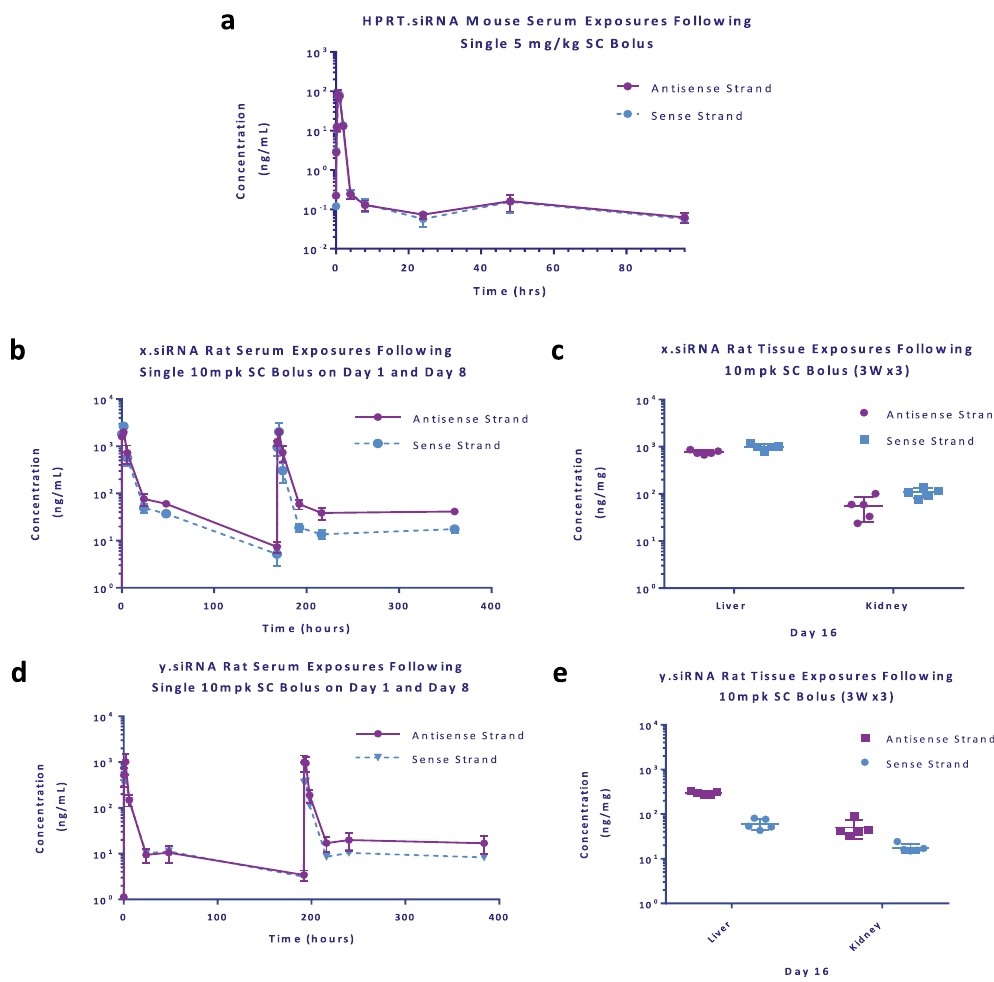
Figure 5. Serum concentration-time profile and tissue concentration of antisense and sense strands of HPRT. siRNA following a single SC bolus in C57BL/6 mice ( a ) 0–96 h in serum (n = 2 animals per time point). Serum concentration-time profile of x.siRNA ( b ) and y.siRNA ( d ) 0–48 h on day 1 and day 8 following a 10 mg/kg SC Bolus in male Sprague Dawley rats. Corresponding tissue concentrations of x.siRNA ( c ) and y.siRNA ( e ) 24 h post-dose following a QWx3 dosing regimen. Rat data plotted as individual replicates (n = 5 animals per time point). Mean data is shown with error bars representing standard deviation.